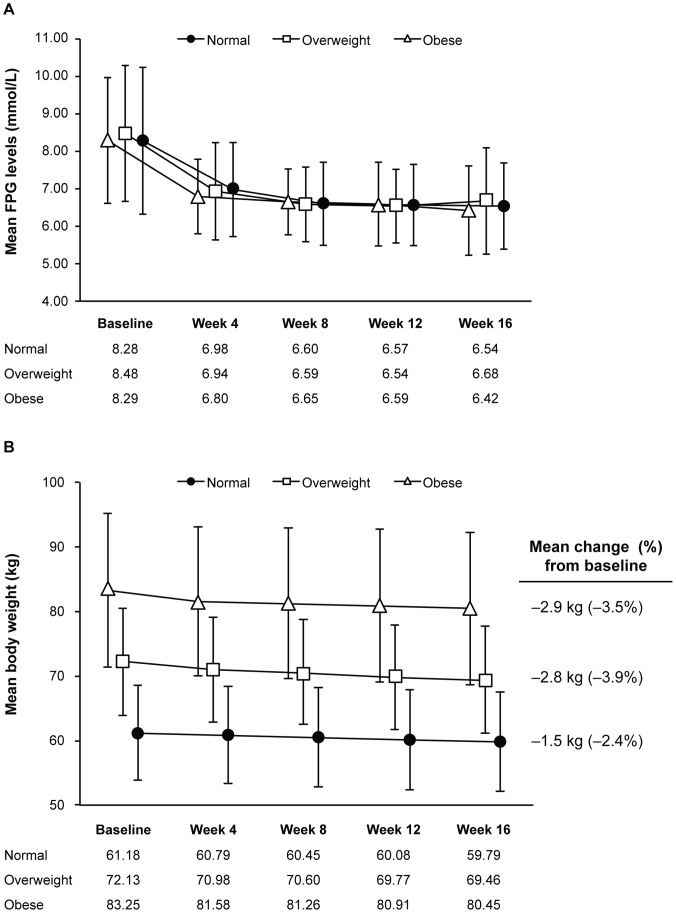
Changes over time according to baseline BMI in the full analysis set population.(A) Mean fasting plasma glucose (FPG) levels; (B) Mean body weight. Error bars represent standard deviation (SD).